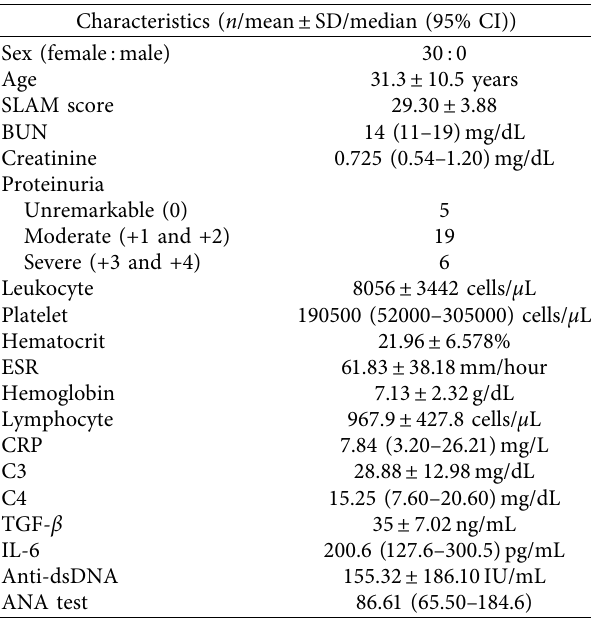
Table 1: Patient’s